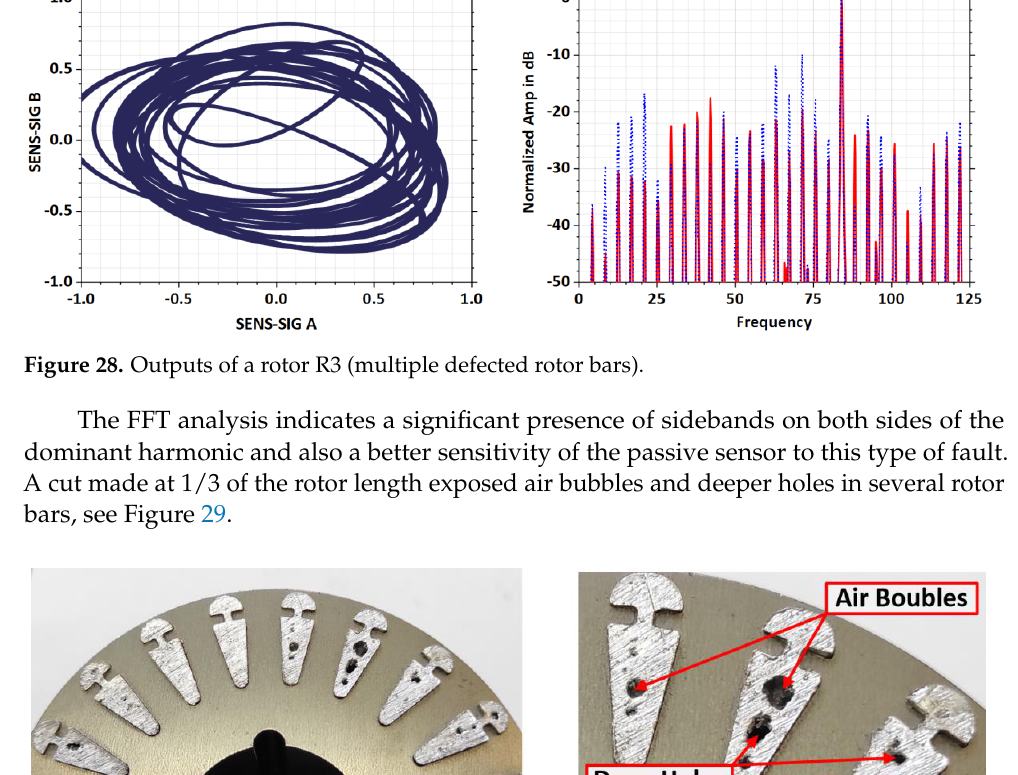
Figure 27. X-ray photography of tested rotor R2 and mechanical cut of end-ring. The rotor labeled R3 presents a sample with a combined fault in the rotor bars, see Figure 28. The internal crossing of the trajectory of the plotting point is characteristic of a fault in the rotor bars.